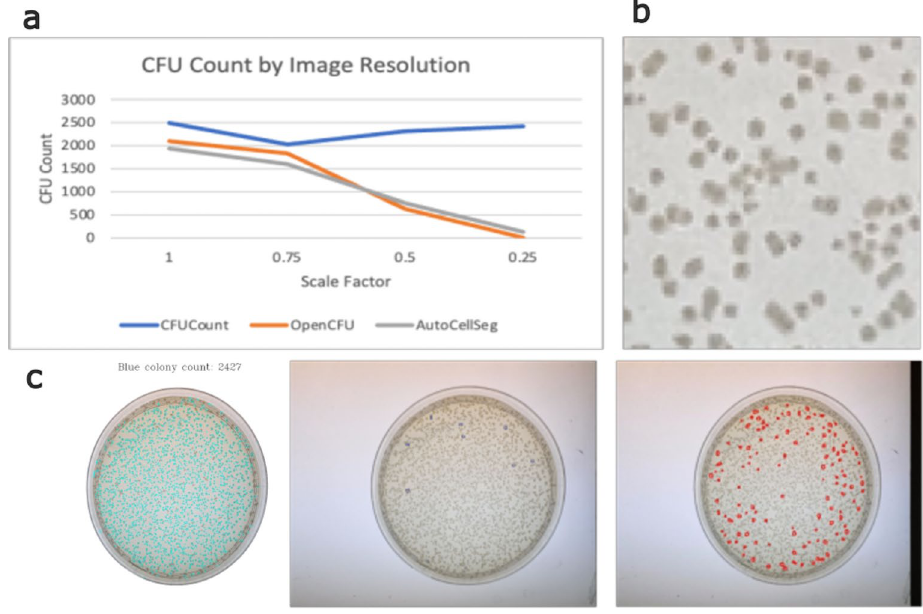
Fig. 5 Impact of image resolution on colony segmentation. a Effect of image resolution on CFU count produced through each method. CFUCounter, OpenCFU, and AutoCellSeg were run on a plate image scaled by a factor of 1, 0.75, 0.5, and 0.25; b Zoomed-in view of the 0.25-scaled plate. Note the high amount of compression noise distorting the colonies; c Segmentation results of the 0.25x-scaled image. From left to right: CFUCounter, OpenCFU, and AutoCellSeg.